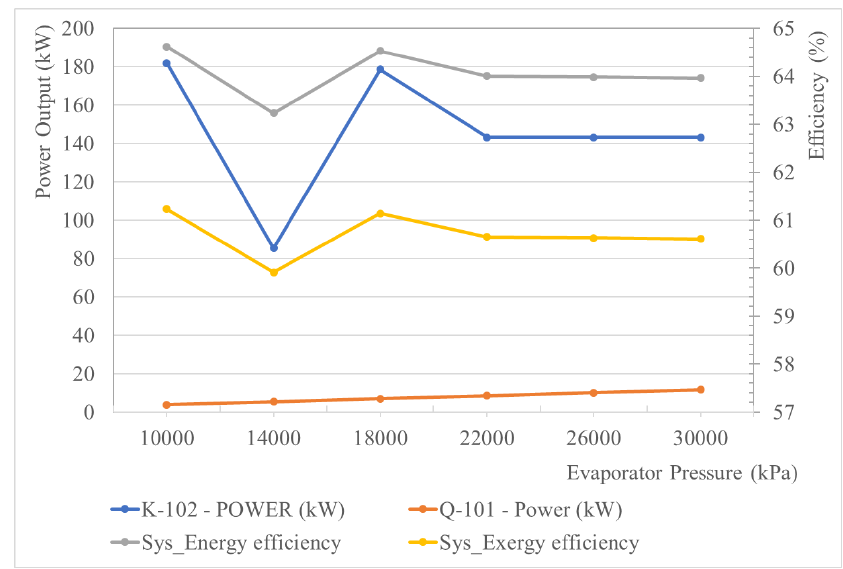
Figure 6. Effect of evaporator pressure on the SRC power output and efficiency.